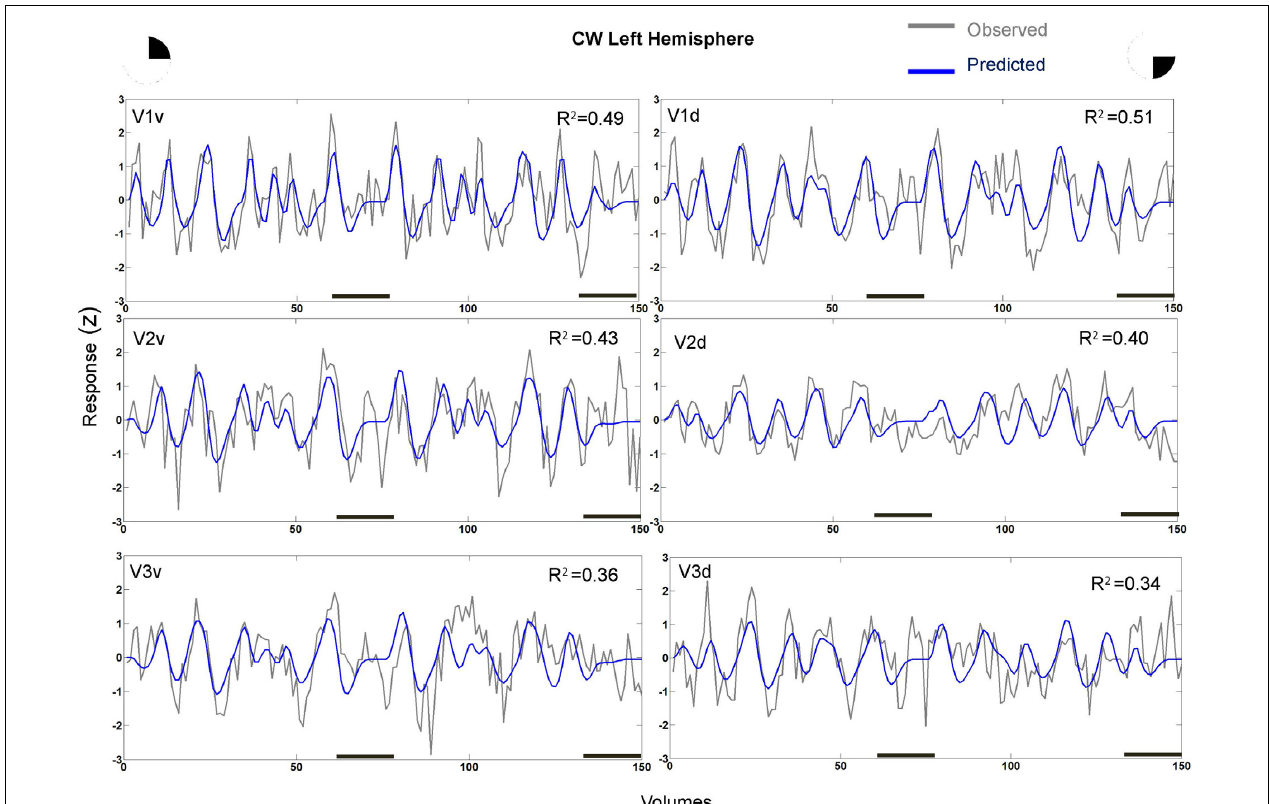
FIGURE 8 | Sample time-series and best-fitting model prediction for example 711 vertices (cortical surface element) in ventral and dorsal V1–V3 areas from CW’s left hemisphere. The dorsal areas correspond to the blind visual